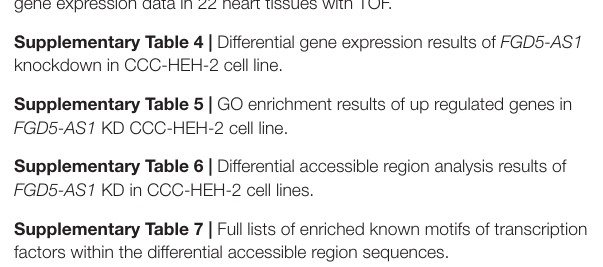
Supplementary Figure 4 | Cell proliferation was measured by flow cytometry in FGD5-AS1 KD CCC-HEH-2 cell line. n.s., not significant; The number of asterisks indicated the corresponding statistical significance ( p-value ). * p < 0.05; ** p < 0.01; *** p < 0.001. Supplementary Figure 5 | FGD5-AS1 decreased the transcriptional expression level of target mRNAs ( SMAD4 and RBSN ). (A) Initial RT-qPCR assays suggested decreased transcriptional level of two mRNAs in FGD5-AS1 KD CCC-HEH-2 cell lines. (B) RT-qPCR assays confirmed the decreased expression of two mRNAs in FGD5-AS1 KD CCC-HEH-2 samples analyzed by RNAseq. n.s., not significant; The number of asterisks indicated the corresponding statistical significance ( p-value ). * p < 0.05; ** p < 0.01; *** p < 0.001. Supplementary Table 1 | Sequences for shRNA as well as miR mimics and primers for PCR; sequences of miRs-mRNAs/lncRNAs binding site for plasmids construction. Supplementary Table 2 | Clinical information of TOF patients.